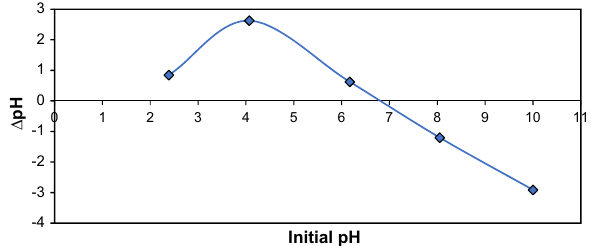
Fig. 8 A linear plot of ∆pH against initial pH of the medium for the determination of pH pzc of